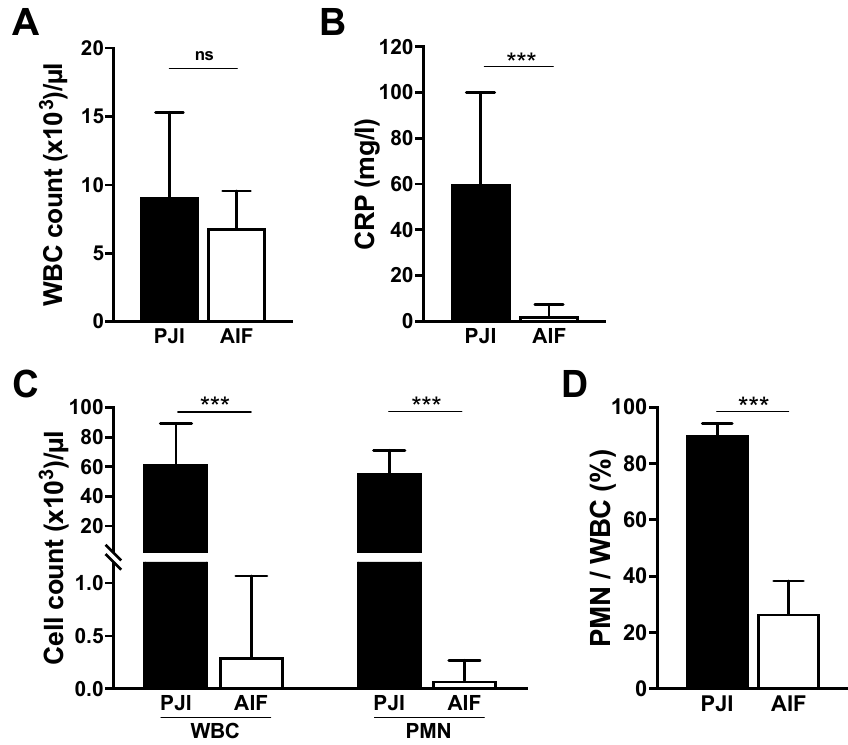
Figure 1. Selected clinical laboratory data of blood and joint aspirates by diagnosis presented as median with error bars indicating the interquartile range (IQR). ( A ) White blood cell count, ( B ) serologic C-reactive protein (CRP) levels, ( C ) white blood cell (WBC) count and polymorphonucleocyte (PMN) count of periprosthetic joint aspirates, ( D ) PMN to WBC ratio in percentage. Mann–Whitney U test with a level of statistical significance of 0.05, * < 0.05, ** < 0.01, *** < 0.001.